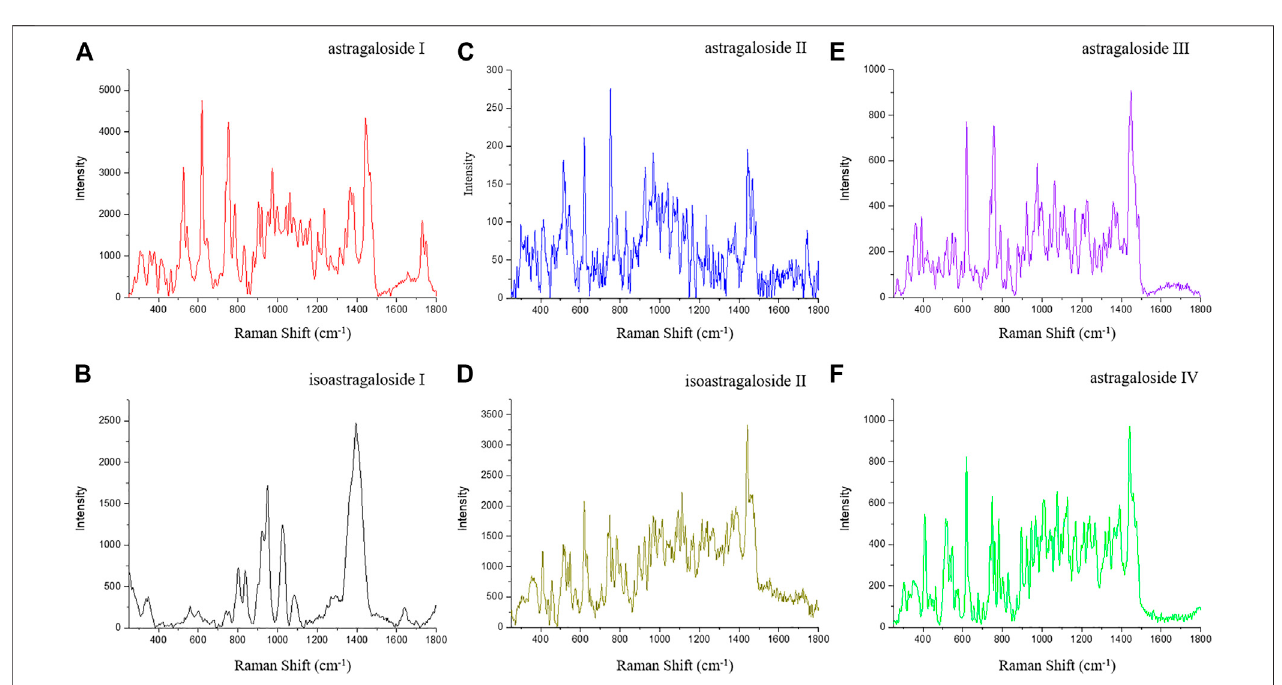
FIGURE 3 | SERS of astragaloside I (A) , isoastragaloside I (B) , astragaloside II (C) , isoastragaloside II (D) , astragaloside III (E) , and astragaloside IV (F) .